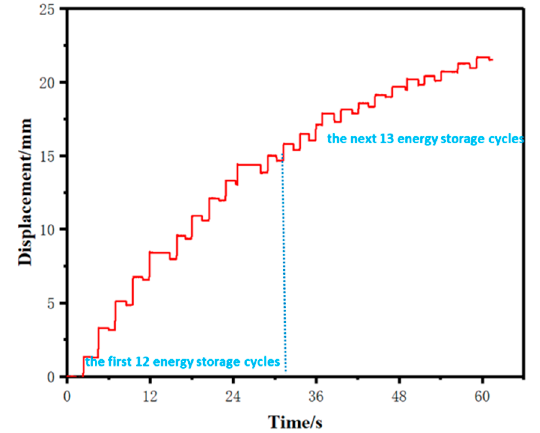
Figure 13. The energy storage process of the jumping robot.